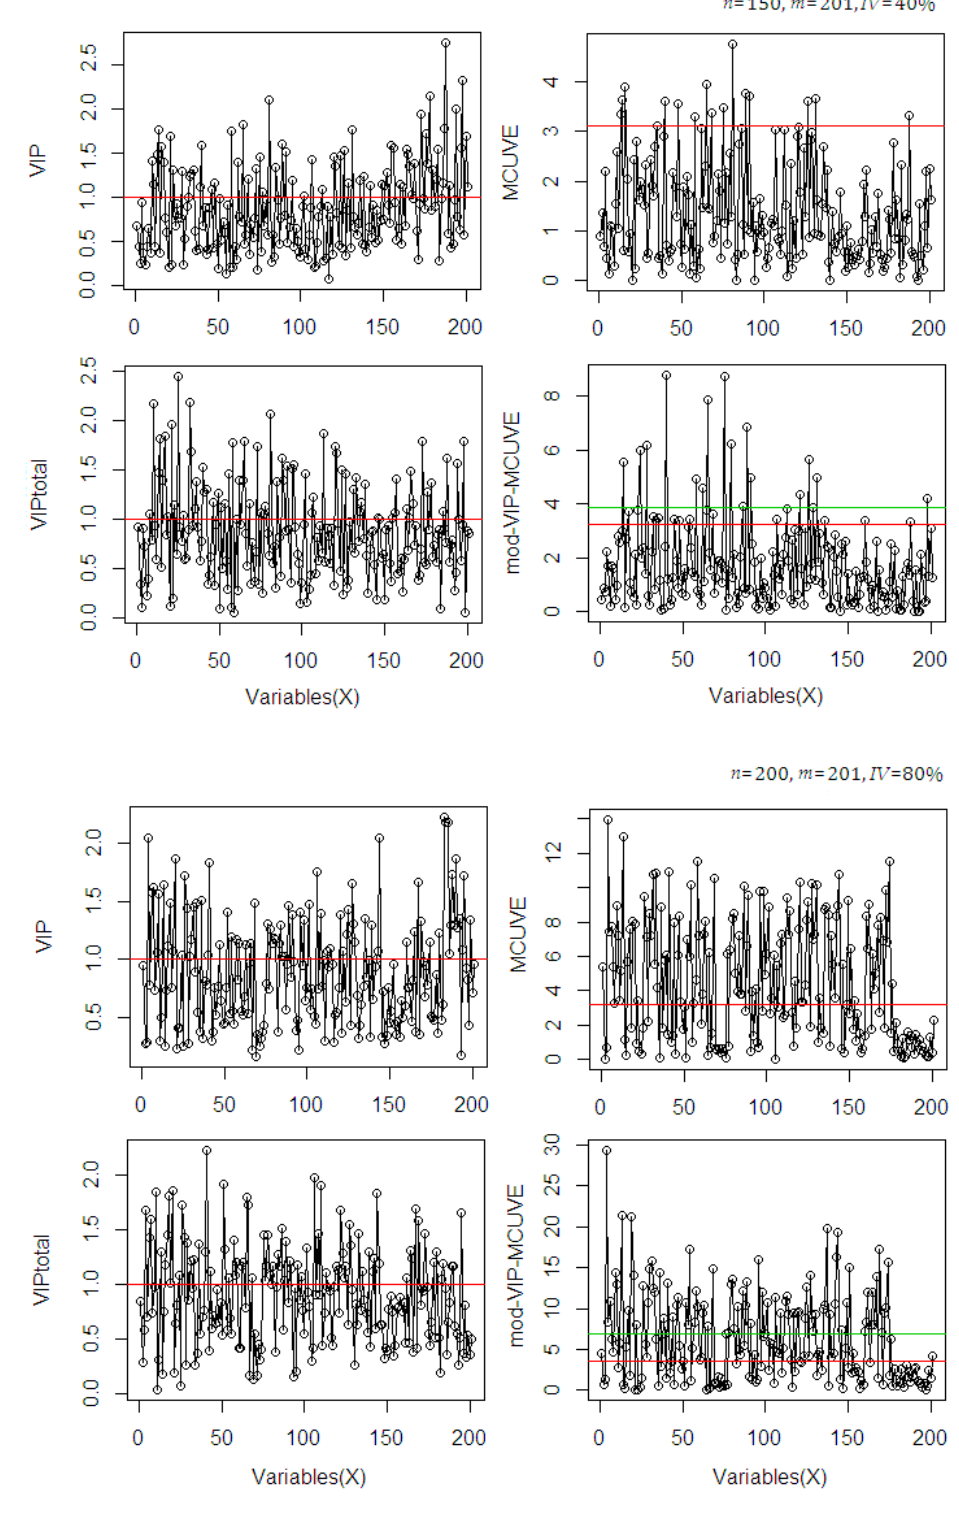
Figure 2. Comparison of the selected relevant variables based on the cut-off criteria in variable selection methods using different dataset scenarios.